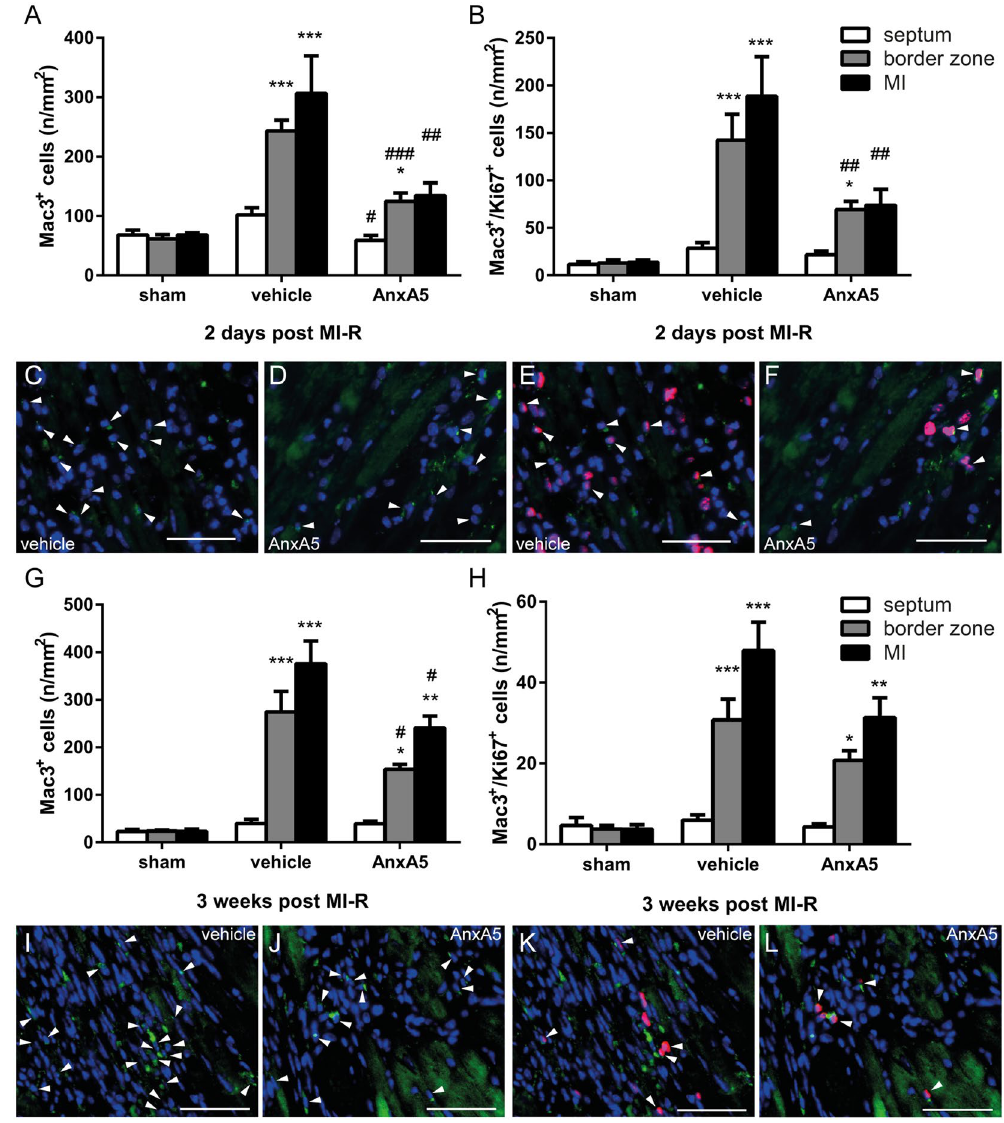
Figure 5. Local inflammatory response and macrophage proliferation. Quantification of the number of infiltrated macrophages showed an decreased number of infiltrated macrophages in the border zones and infarct area two days (n = 3–5) following MI-R in the AnxA5 group ( A ). Mac3/Ki67 double staining revealed a significant reduction in the number of proliferating macrophages in the border zones and infarct area after two days in the AnxA5 treated mice as compared to vehicle (n = 5–6; B ). Three weeks after MI-R the number of infiltrated macrophages is significantly reduced in the border zones and infarct area upon AnxA5 treatment ( G ). No differences were observed regarding the number of proliferating macrophages three weeks after MI-R between AnxA5 and vehicle groups ( H ). Representative images of Mac3 staining ( C , D , I and J ) and Mac3/Ki67 double staining ( E , F , K and L ) of the infarct area. Nuclei are shown in blue, Mac3 staining in green and Ki67 in red, arrowheads indicate positive cells. Scale bar: 50 μ m. Data are mean ± SEM. # P,0.05, ## P < 0.01, ### P < 0.001 all vs. vehicle, * P < 0.05, ** P < 0.01 and *** P < 0.001 all vs.